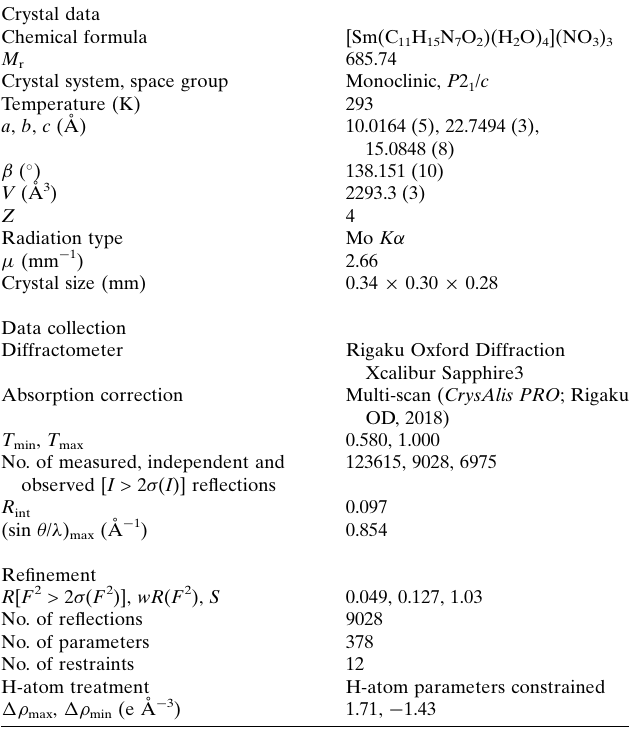
Crystal data Chemical